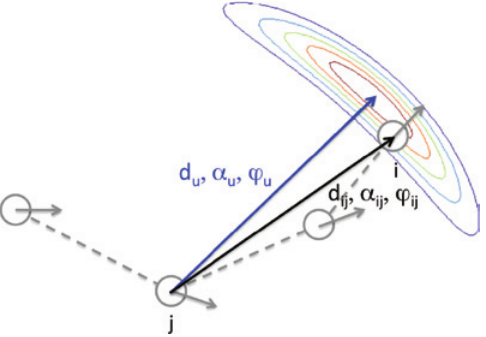
Figure 5. The Evolution Model Including Odometry and Relative Node